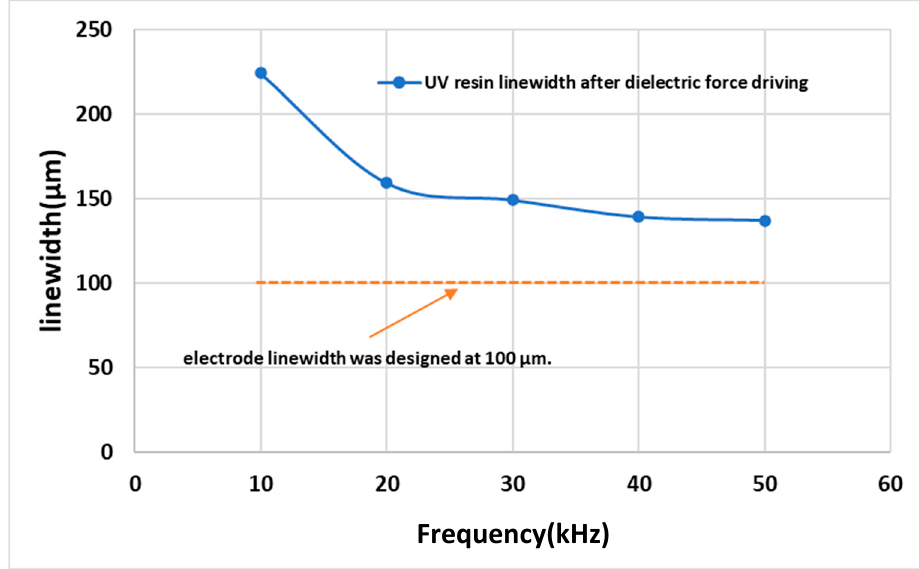
Figure 9. Comparison of electrode linewidth and UV-resin linewidth after being driven. Voltage was 200 V and current was 0.3 A.